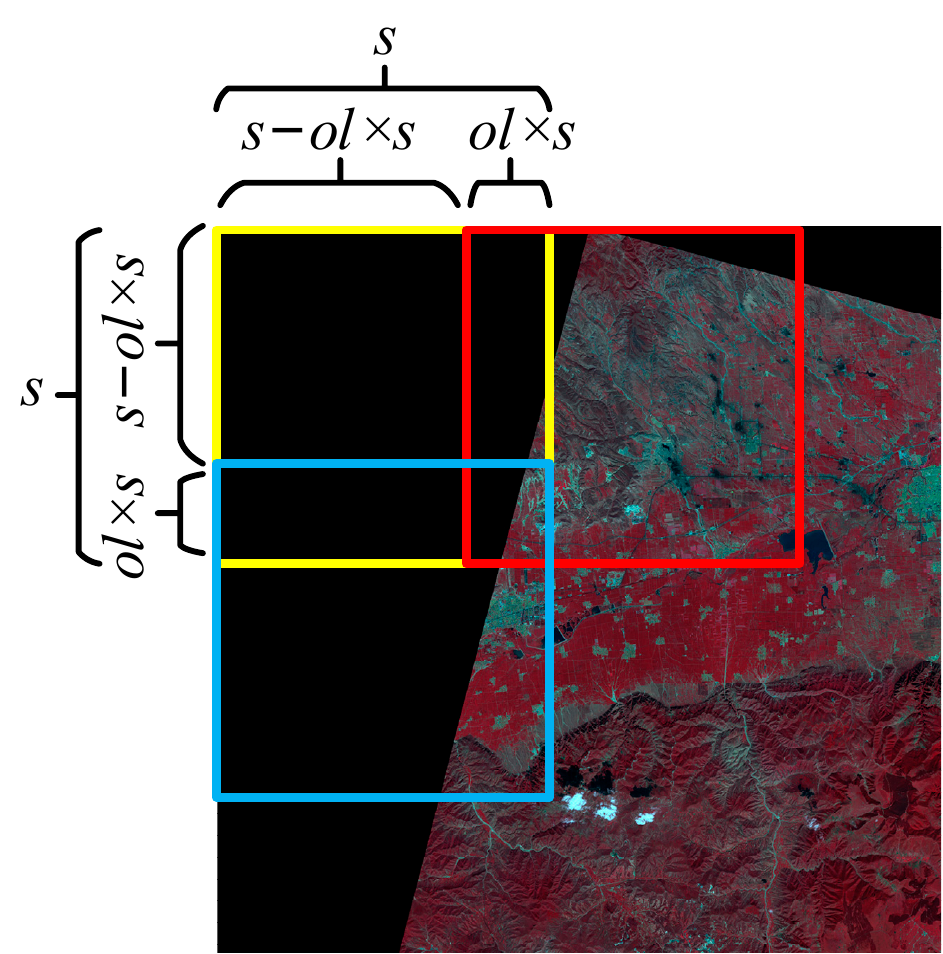
Figure 10. Overlapping slices of large-scale imagery.